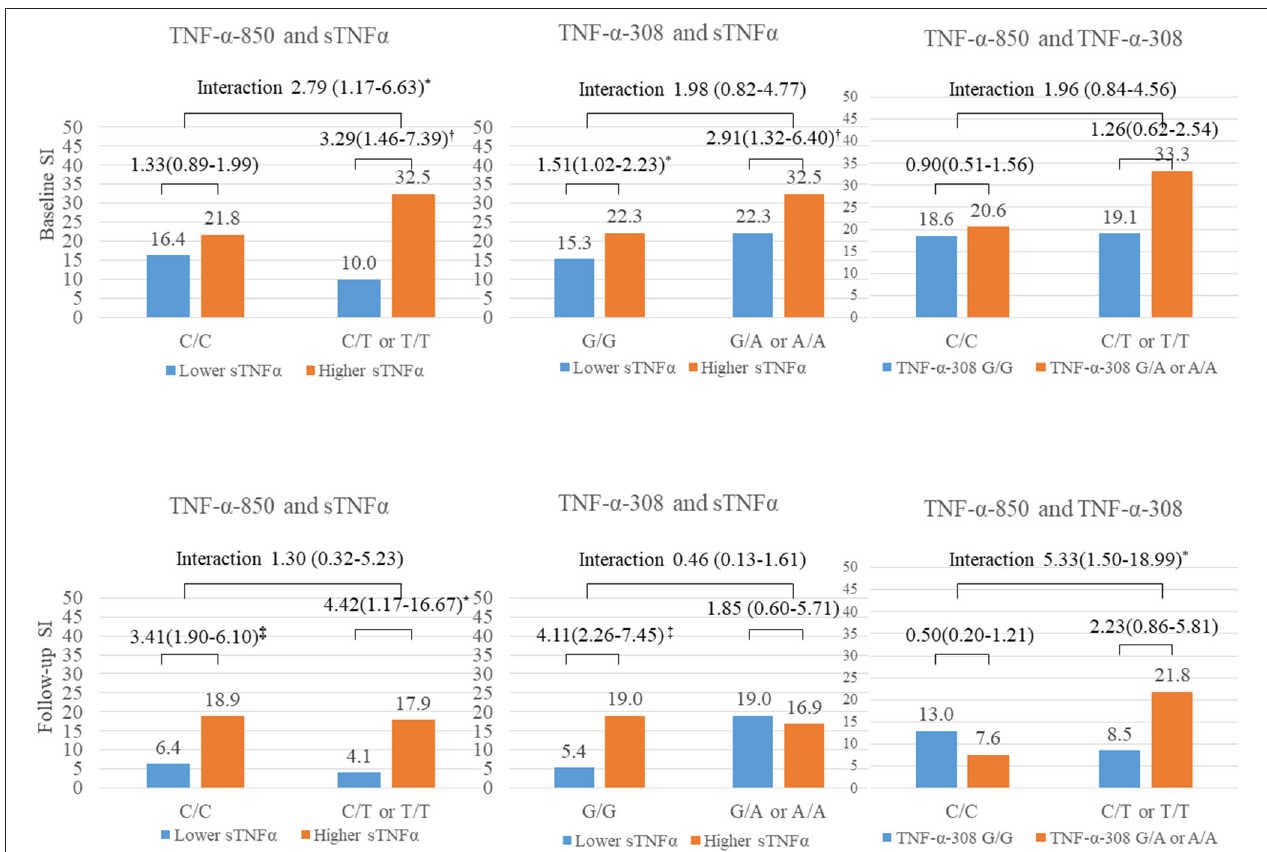
FIGURE 2 | Interactive effect of tumor necrosis factor-alpha (sTNF α ) level and two polymorphisms on suicidal ideation (SI) 2 weeks and 1 year after acute coronary syndrome (ACS). TNF- α , tumor necrosis factor-alpha; sTNF α , serum TNF- α level; SI, suicidal ideation. * P < 0.05; † P < 0.01; ‡ P <